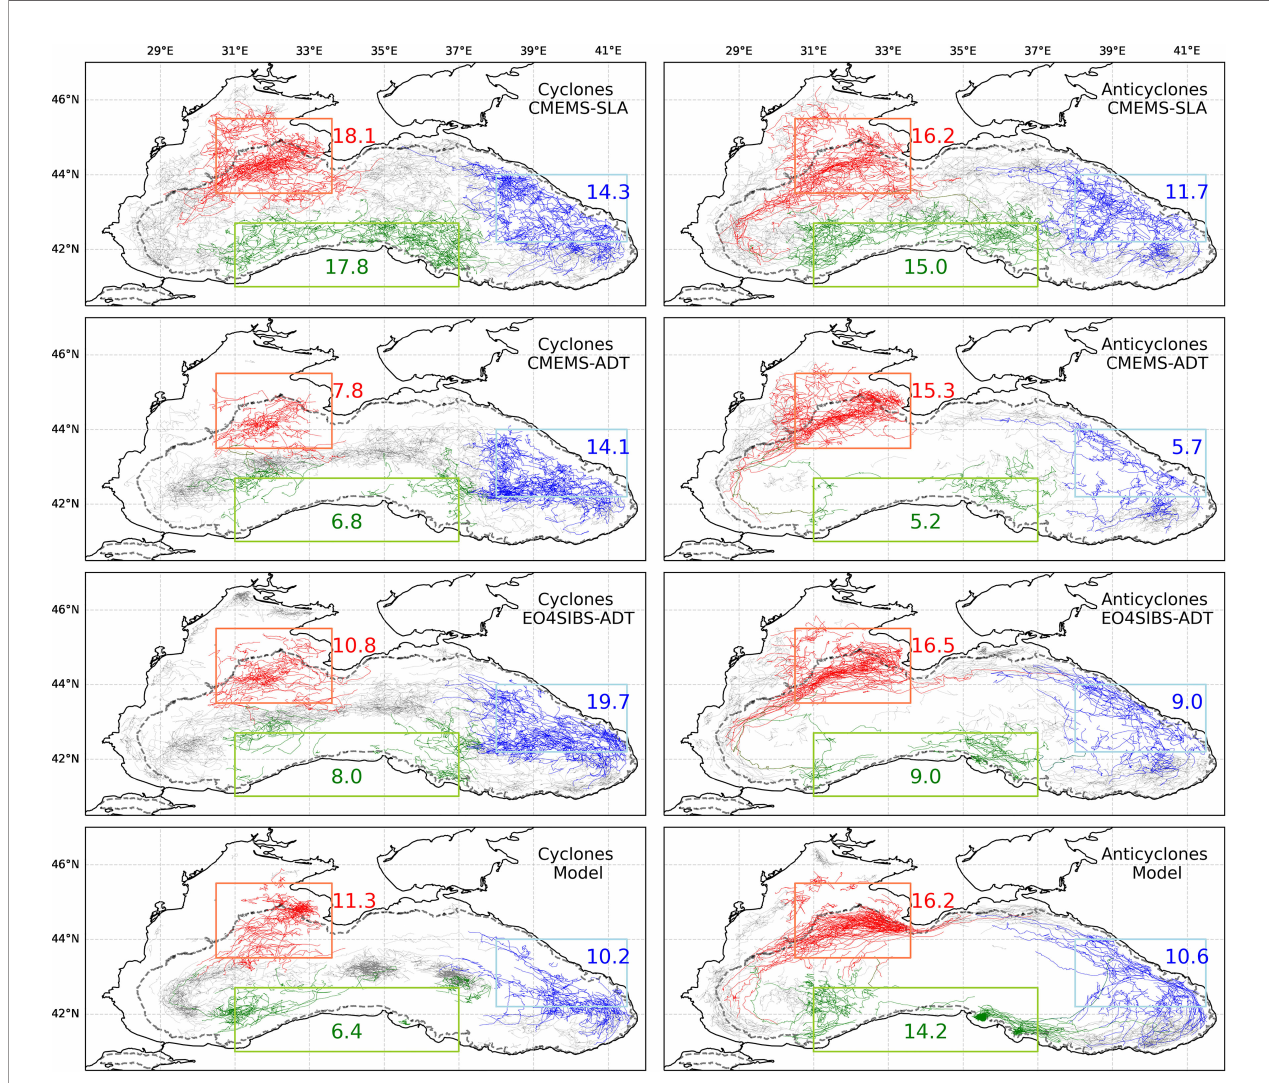
FIGURE 8 | Dominant cyclone (left) and anticyclone (right) pathways for three shelf regions of the Black Sea, as obtained from the different data sets. All the identi fi ed eddy tracks are displayed in grey. Tracks crossing the colored boxes are then highlighted in the same color as the box. The colored numbers provide the yearly count of such tracks for each of the three regions. The dotted line indicates the 200m isobathymetric